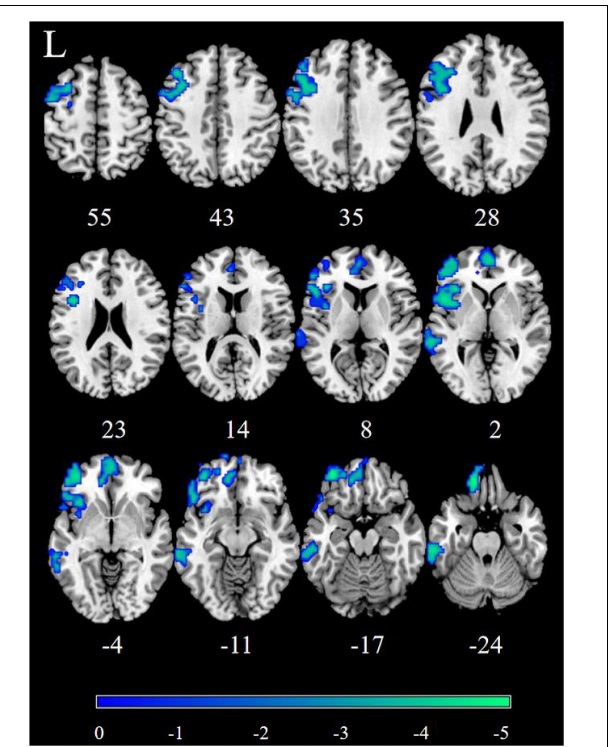
FIGURE 3 | Significantly decreased dynamic functional connectivity (DFC) of the right nucleus accumbens (NAc) in patients, compared with HC. The blue regions in the brain slices present the location of difference (GRF